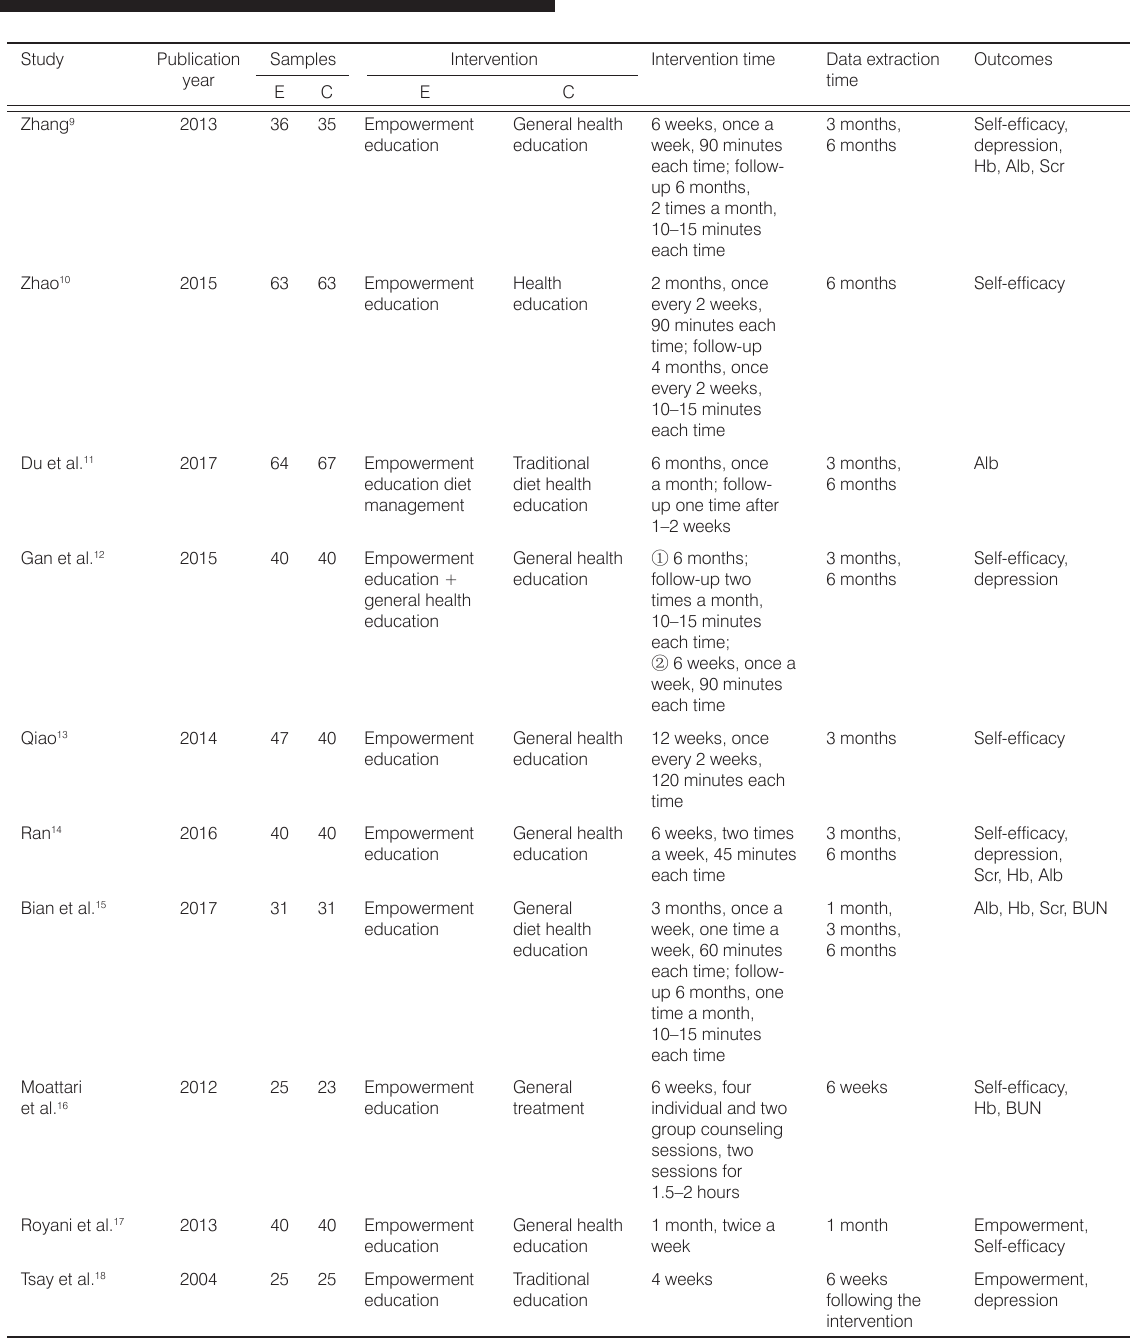
Table 1. Basic characteristics of the included